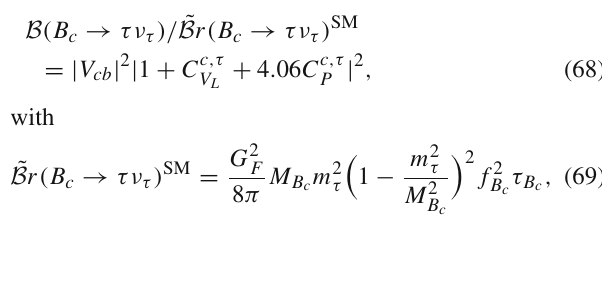
following from F L ( D ∗ ) (left) and R ( D ∗ ) R